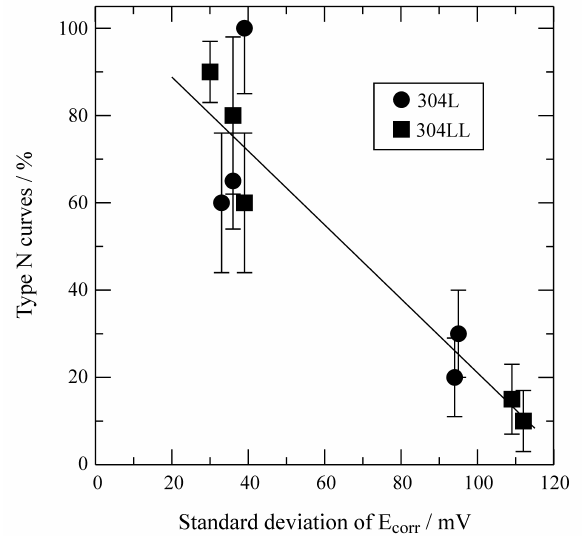
Figure 4. Percentage of obtained type N curves [data from Ref. (8)] as a function of corrosion potential E corr standard deviation.